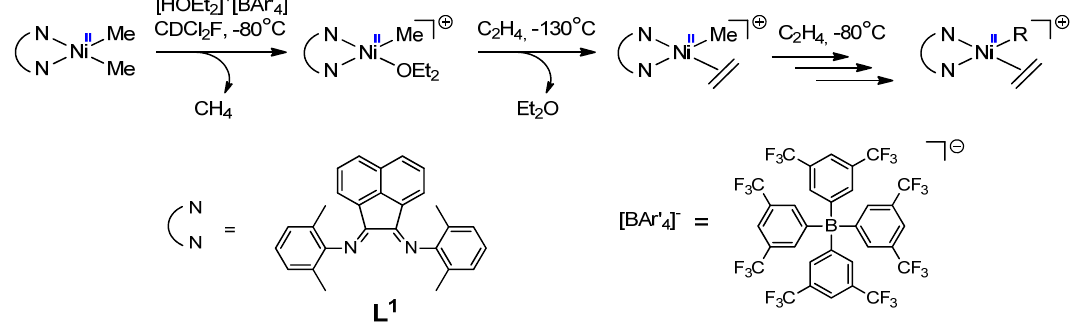
Scheme 1. Ethylene coordination, insertion, and polymer chain growing in the model catalyst system [ L 1 Ni II Me(Et 2 O)] + [BAr ′ 4 ] − /C 2 H 4 (Ar ′ = 3,5-C 6 H 3 (CF 3 ) 2 )